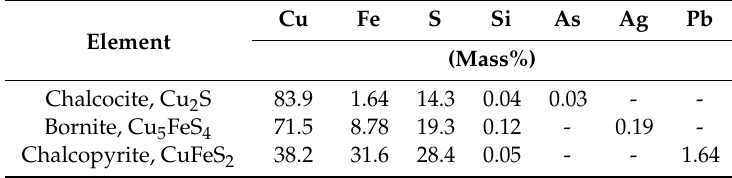
Table 2. Chemical composition of chalcocite, bornite, and chalcopyrite samples. Element